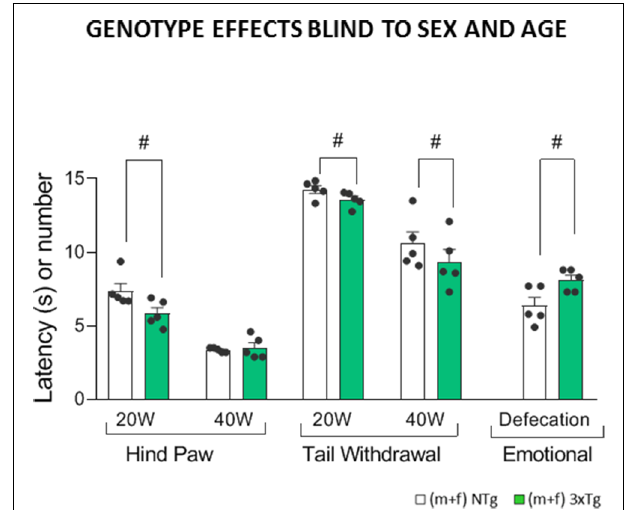
FIGURE 3 | Genotype effects in the Sensory-discriminative and affective-emotional dimensions blind to sex and age in 3xTg-AD and NTg mice with normal aging. Represented by hind paw withdrawal responses at low (20-W) and high intensity (40-W), Tail withdrawal at low (20-W) and high intensity (40-W) and total defecations. Groups: NTg, non-transgenic mice (open bar); 3xTg-AD, transgenic mice (green bar). Error bars represent mean ± SEM. Statistics: Student t -test comparisons are shown in the graphs as # p < 0.01 vs. the NTg-group.